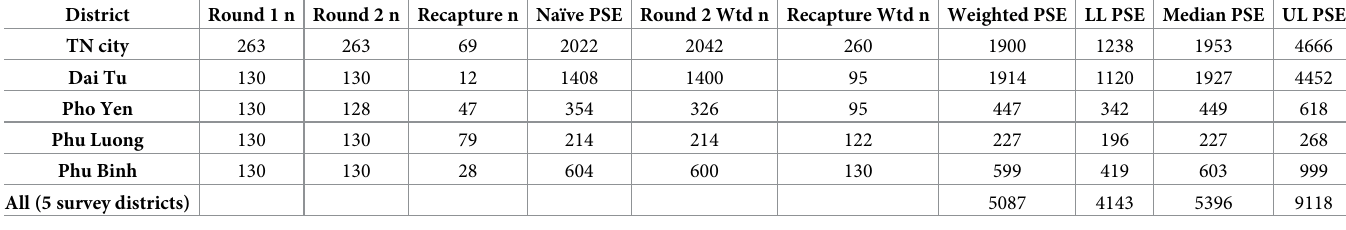
Table 1. Weighted PS estimate (CRC) in survey